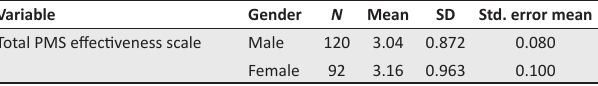
TABLE 5: Descriptive statistics of the differences in the mean perception scores of the performance management system effectiveness between men and women. Variable Gender N Mean